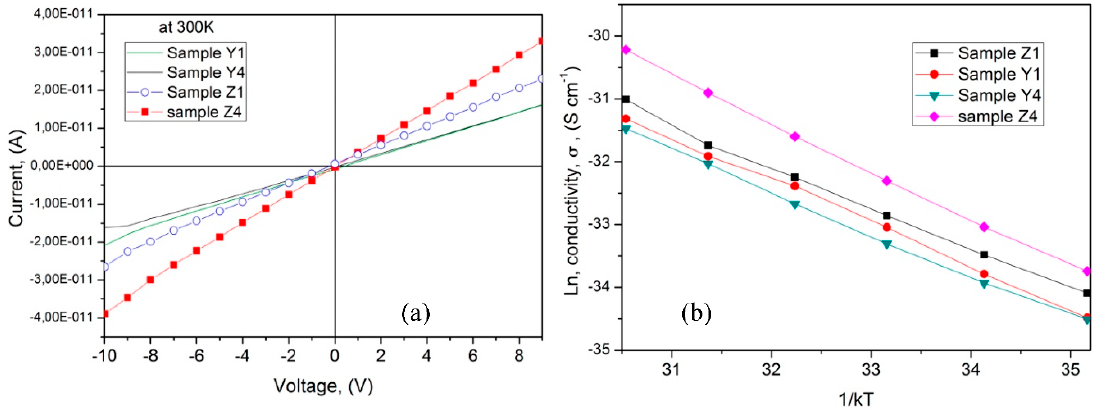
Figure 11. ( a ) I-V characteristic for the PVA/ZnO membranes at room temperature, ( b ) DC conductivity as a function of temperature.